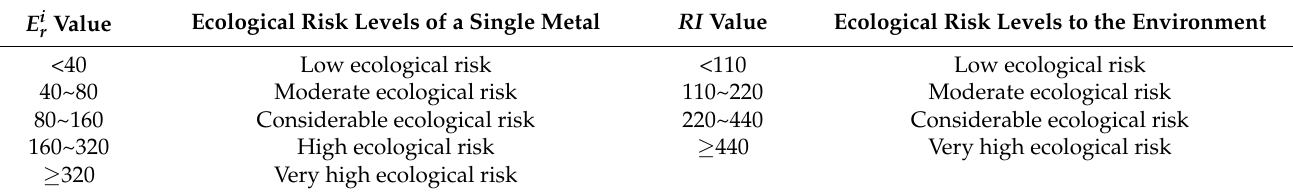
Table 2. The adjusted E i r and RI classification